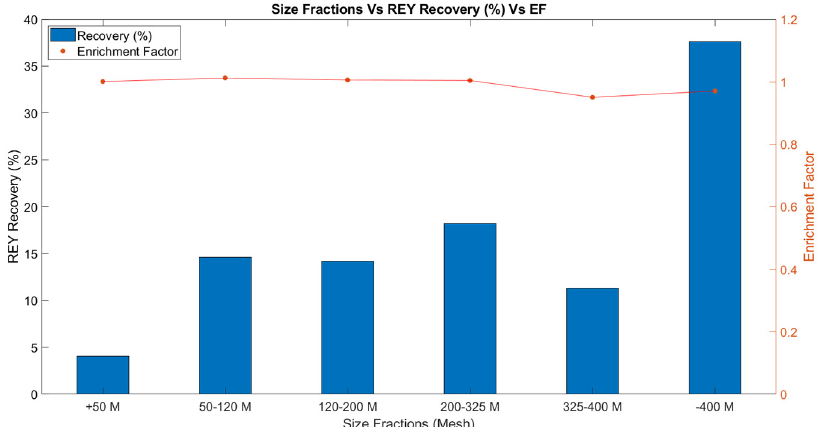
Figure 5. Enrichment factor and REY recovery in the various size fractions.